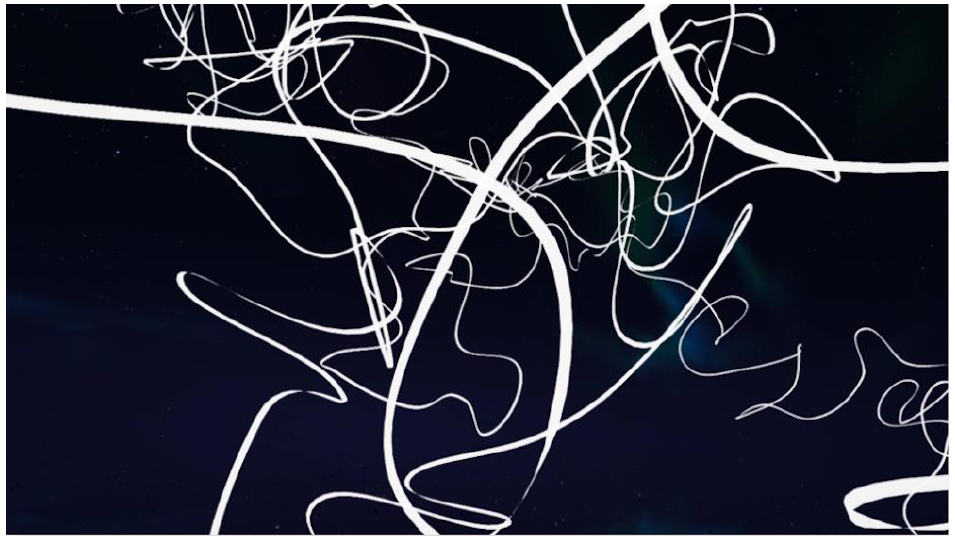
Figure 5. Screenshot from Binaural Odyssey application, featuring an element labeled fast white line in this article.